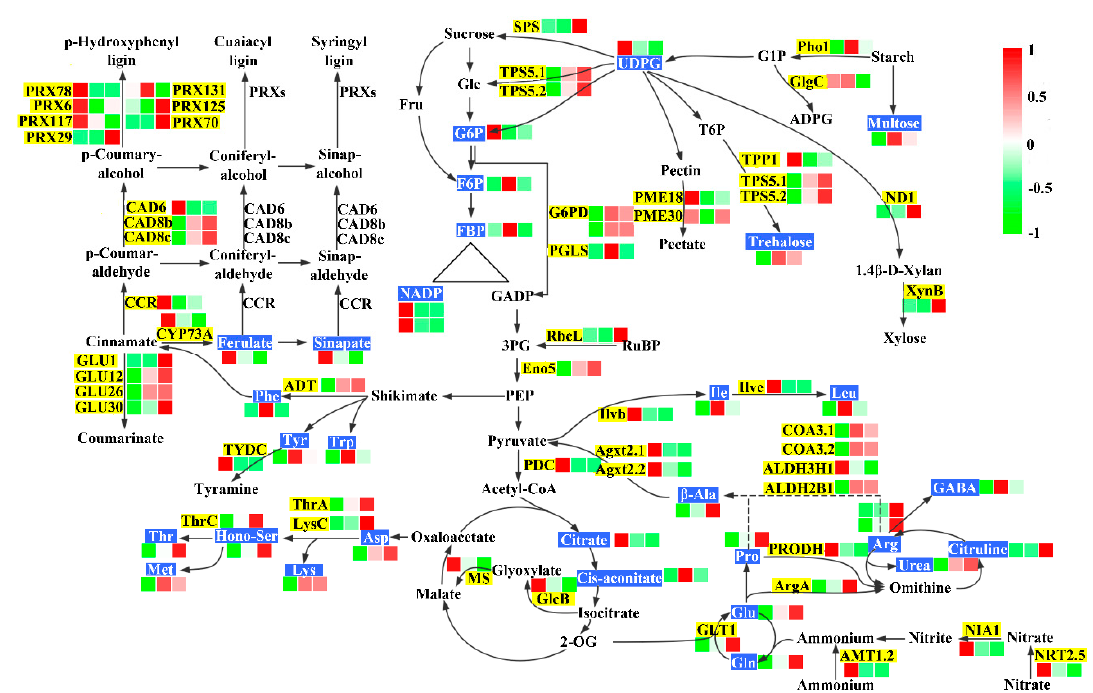
Figure 3. Carbon and nitrogen metabolism pathways overrepresented among differentially expressed genes and significantly changed metabolites. Black characters with yellow background are genes, while white characters with blue background are metabolites. The three squares under the gene and metabolites names indicate expression abundance or metabolite levels of low N, control N, and high N.